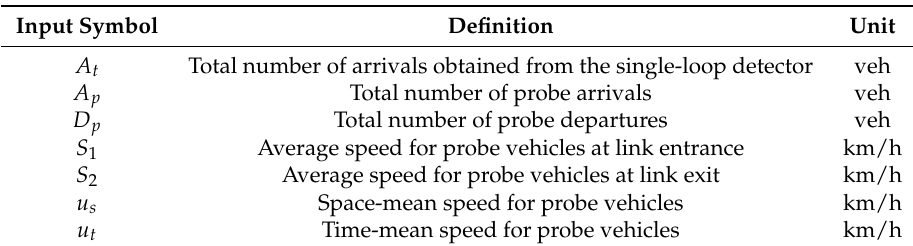
Table 1. Definition of the NN model